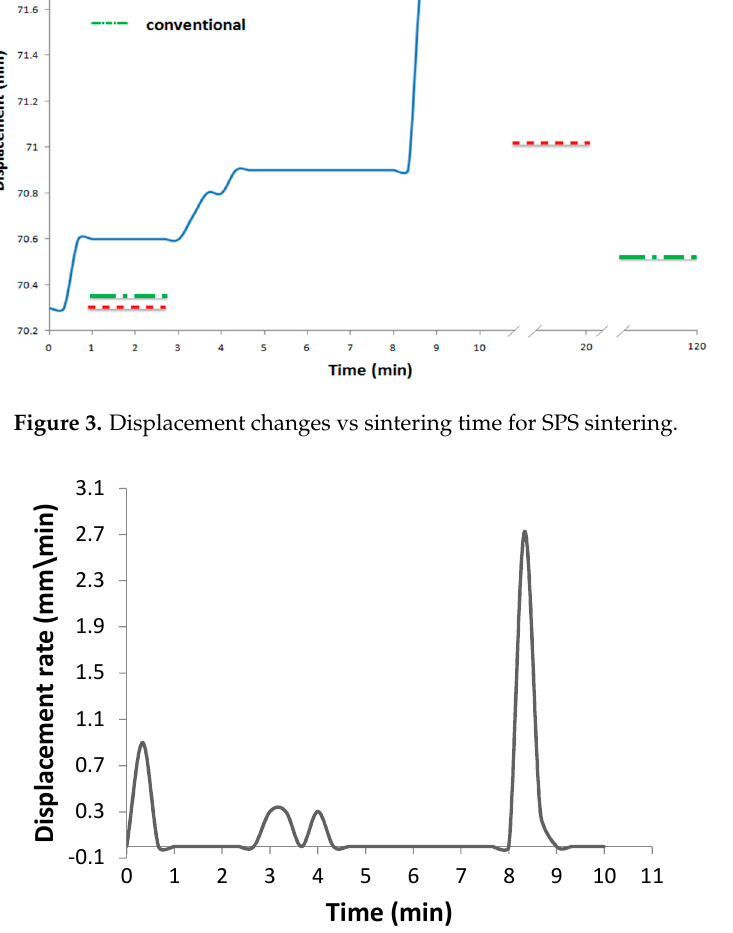
Figure 4. Displacement rate vs sintering time for the SPS sample.